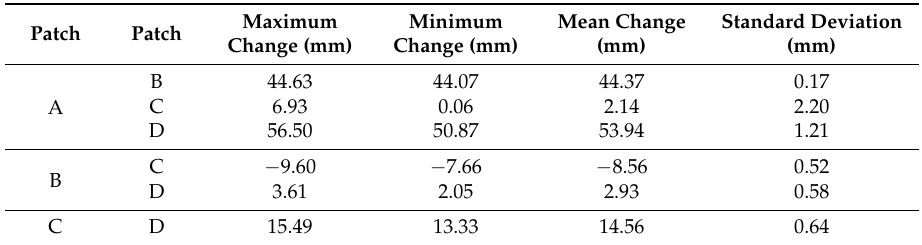
Figure 16. Baseline length changes between virtual brick centre points. Table 2. Baseline change between patches.